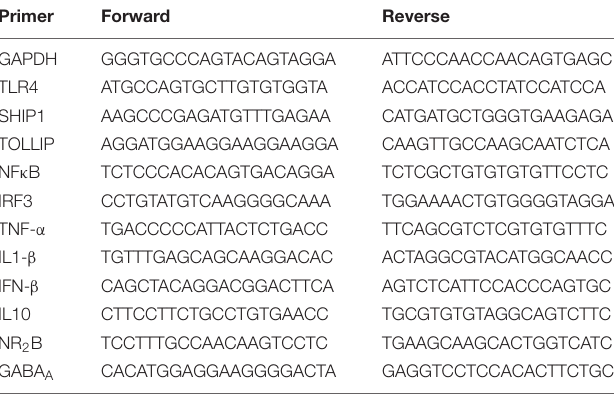
TABLE 1 | List of primer sequences used for RT-PCR